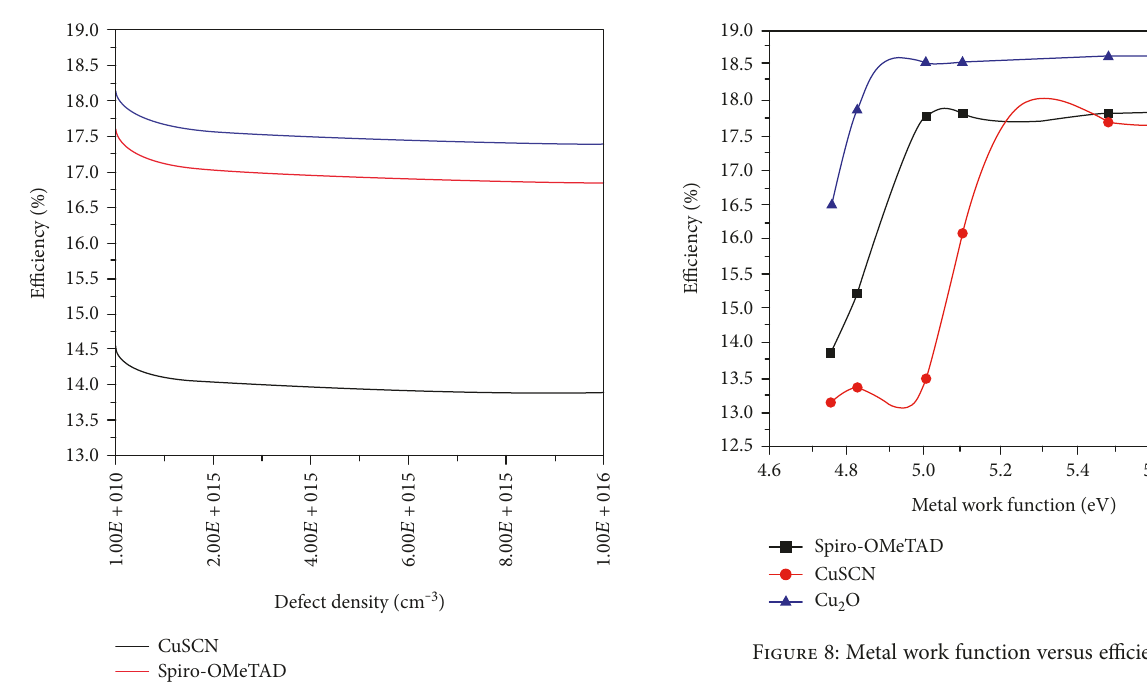
NH SnI /HTM layer versus 3 3 3